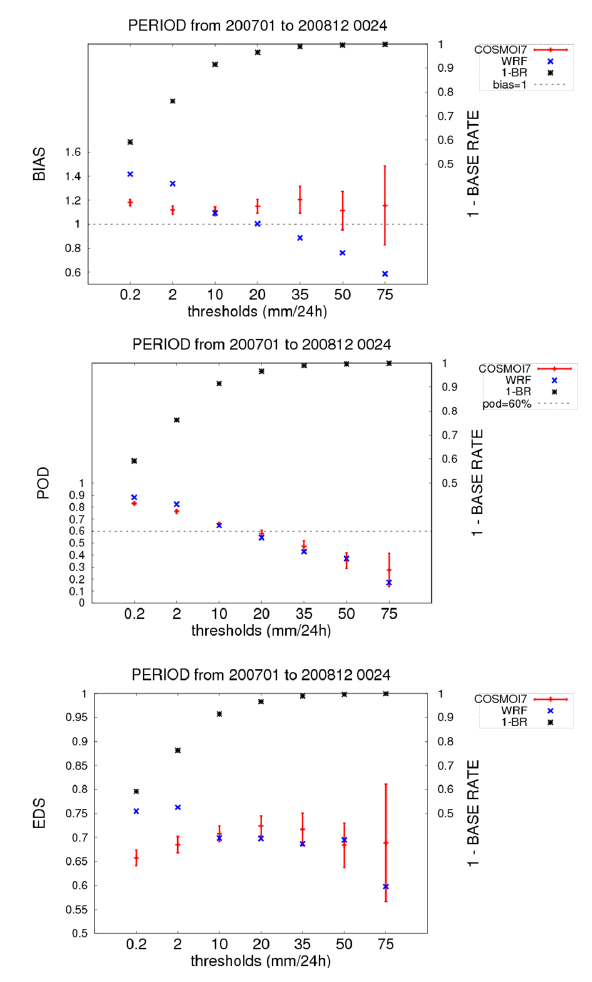
Fig. 4. Long-period verification: BIAS, POD, EDS vs. increasing thresholds for the first day of forecast. The dashed red lines and the blue daggers represent COSMO-I7 and WRF, respectively. The Base Rate (stars) is plotted for each